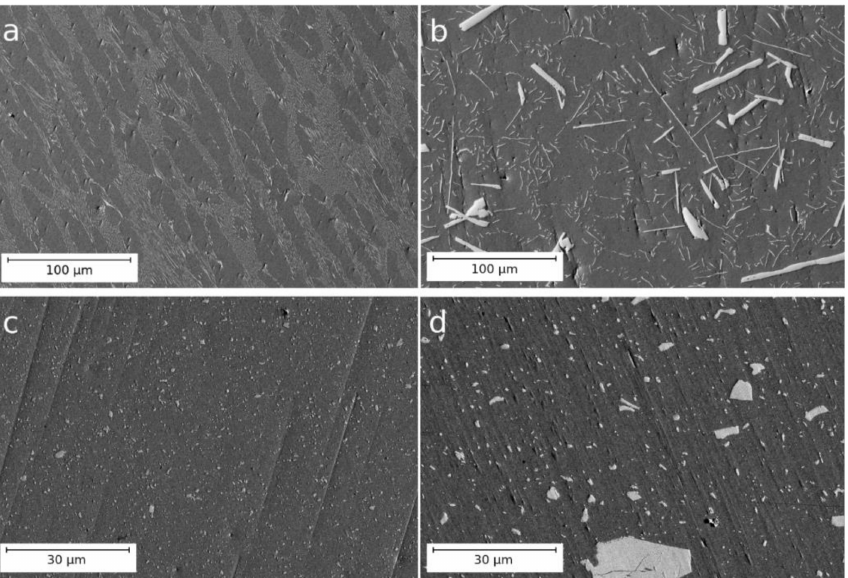
Figure 1. Backscattered SEM images of the samples of the Al-2Fe and Al-4FE alloys: ( a ) Al-2Fe as-cast, ( b ) Al-4Fe as-cast, ( c ) Al-2Fe after HPT, ( d ) Al-4Fe after